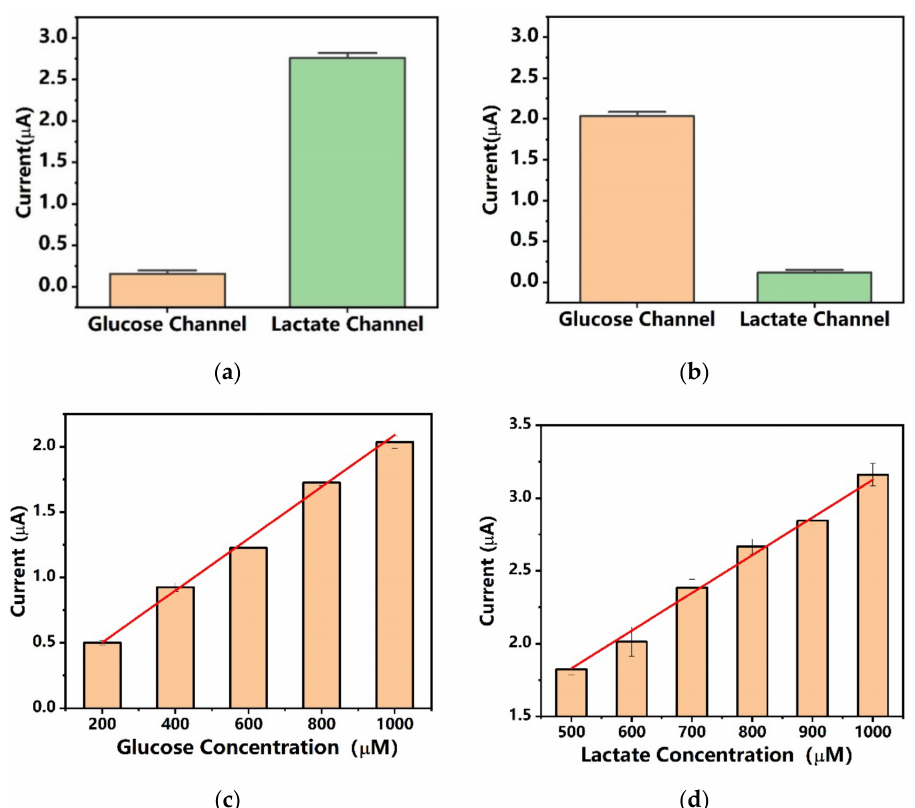
Figure 6. The current response from the two channels of the dual-analyte biosensor with spiked human saliva samples. ( a ) The measured current of the dual-analyte biosensor using human saliva sample 11 spiked with 0 µ M glucose and 1000 µ M lactate ( N = 3). ( b ) The measured current of the dual-analyte biosensor using human saliva sample 5 spiked with 1000 µ M glucose and 0 µ M lactate ( N = 3). ( c ) The measured current of the glucose detection channel using human saliva samples 1, 2, 3, 4, and 5 spiked with 200, 400, 600, 800, and 1000 µ M glucose ( N = 3). ( d ) The measured current of the lactate detection channel using human saliva samples 6, 7, 8, 9, 10, and 11 spiked with 500, 600, 700, 800, 900, and 1000 µ M lactate ( N =